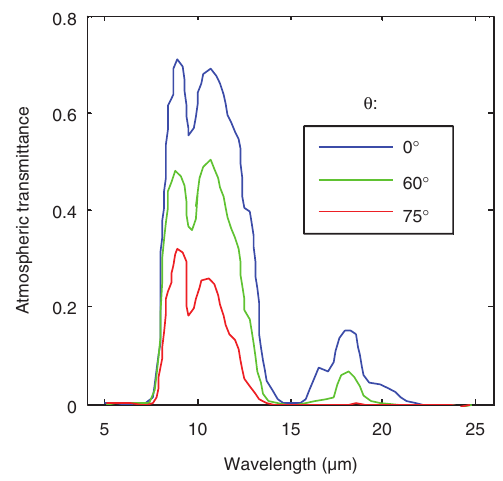
Figure 1: The atmospheric transmittance spectrum at zenith angles of 0 ° , 60 ° , and 75 ° ; it is highest in the 8–13 μ m transparency window. Results are adapted from [2].